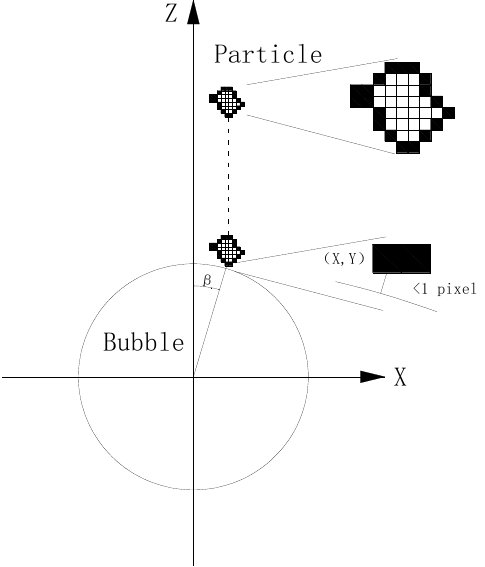
Figure 4. Schematic of collision angle solving method.